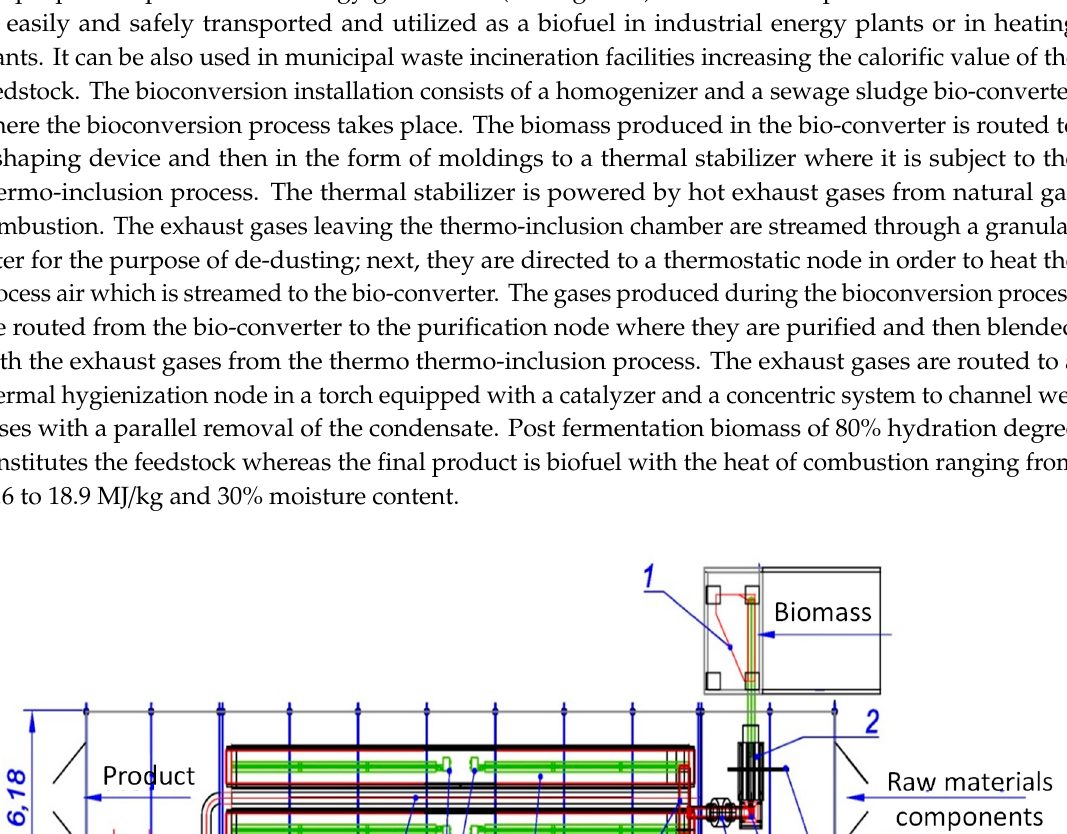
Table 2. Optimal content of the mixture.